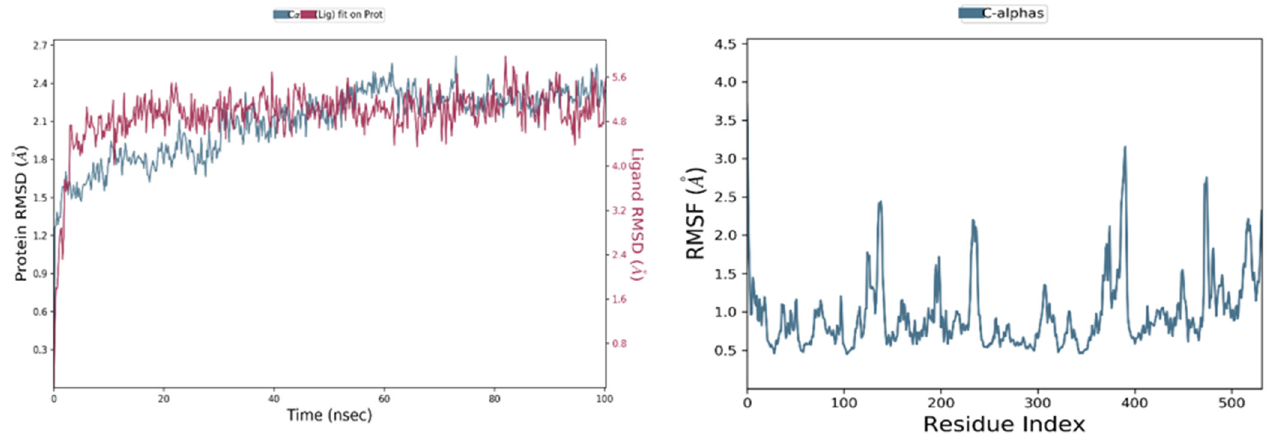
Figure 11. RMSD and RMSF graphs for the ligand 9 complexed with the dopamine transporter membrane protein during 100 ns.